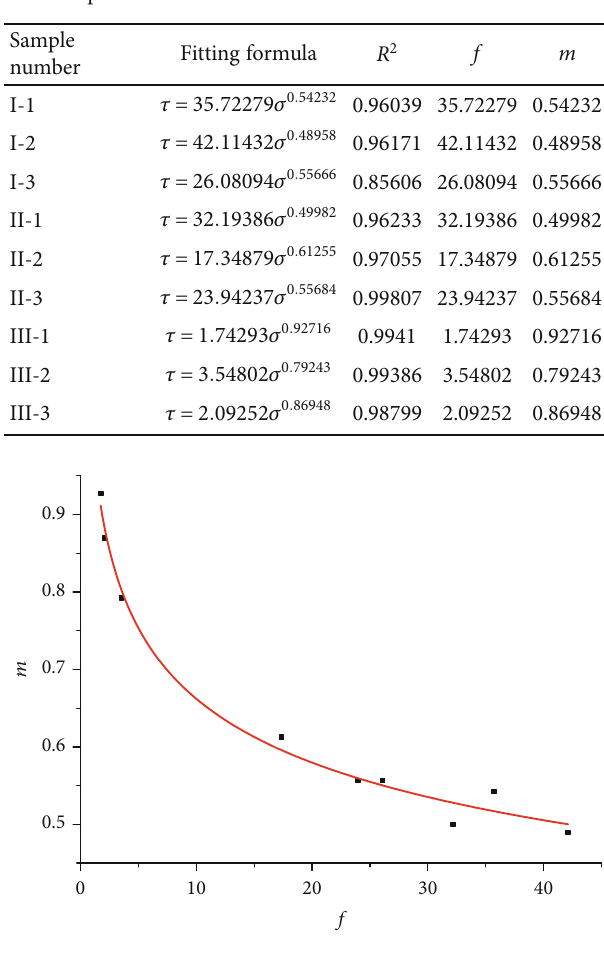
Figure 7: Relation curve of m and